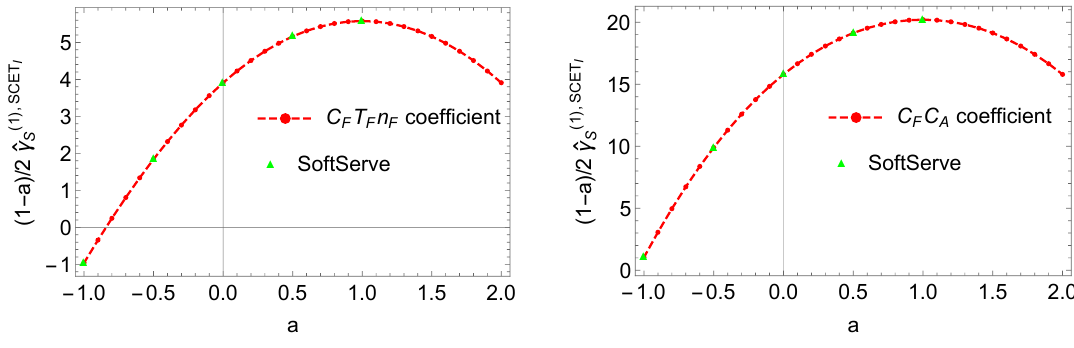
Figure 6 . Soft anomalous dimension for angularities (multiplied by (1 − a ) / 2 ) corresponding to the parameter a : coefficient of T